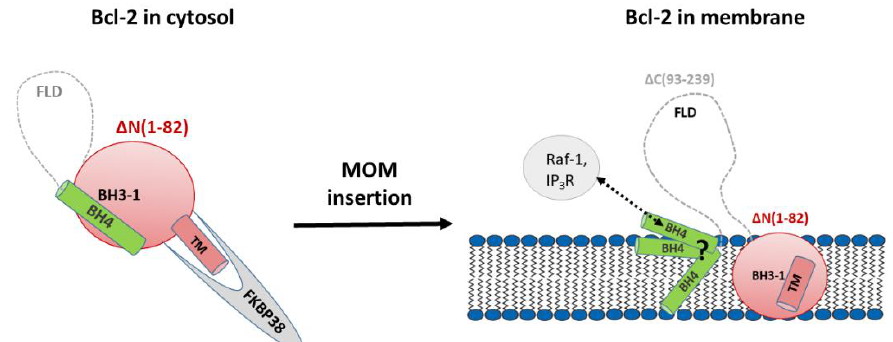
Figure 2. Our working concept: Schematic representation of the full length Bcl-2 sequence showing soluble Bcl-2 with the mitochondrial chaperone FKBP38 binding via the TM domain in the cytosol (left), which helps to transport Bcl-2 to the MOM by a still mysterious mechanism [26,27]. In the membrane, the Bcl-2 domain organization (right) based on the functions is shown as N-terminal BH4, FLD, and C-terminal BH3-1 TM domains. N-terminal domains are known to interact with IP 3 R and Raf-1 proteins [23 – 25], while C-terminal BH3-1 domains are known to interact with BH3-only proteins, interactions which are involved in apoptosis.